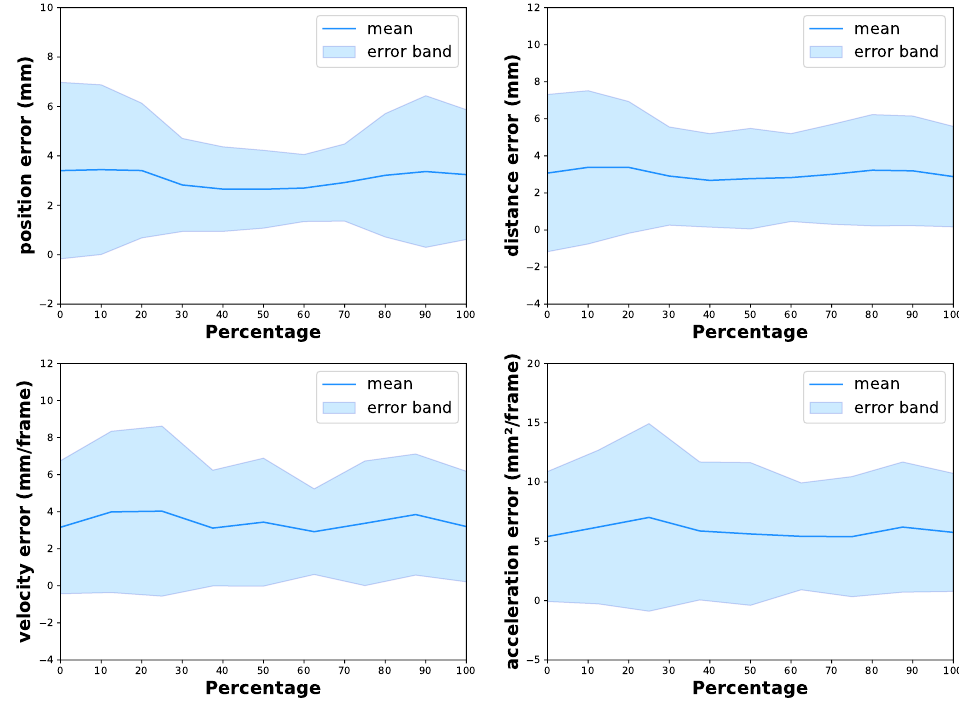
Figure 13. Prediction error bands of SARN during the moving